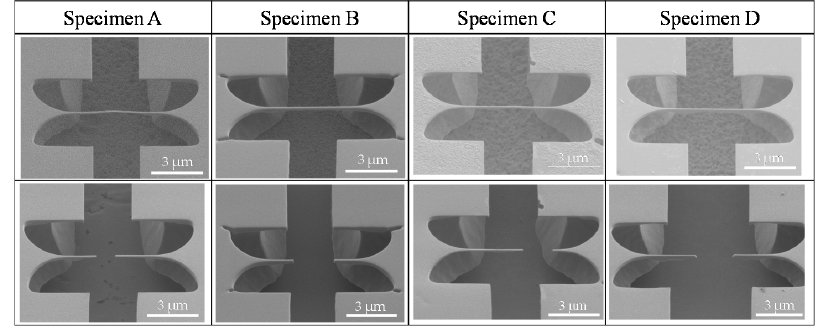
Figure 6. Tensile-tested specimens. ( Upper row ) before testing. ( Lower row ) after fracture. Table 1. Properties of tested specimens. Details on two types of device design are described in the Supplemental Material. Specimen width and linewidth reduction in test device structures were measured after oxidation.